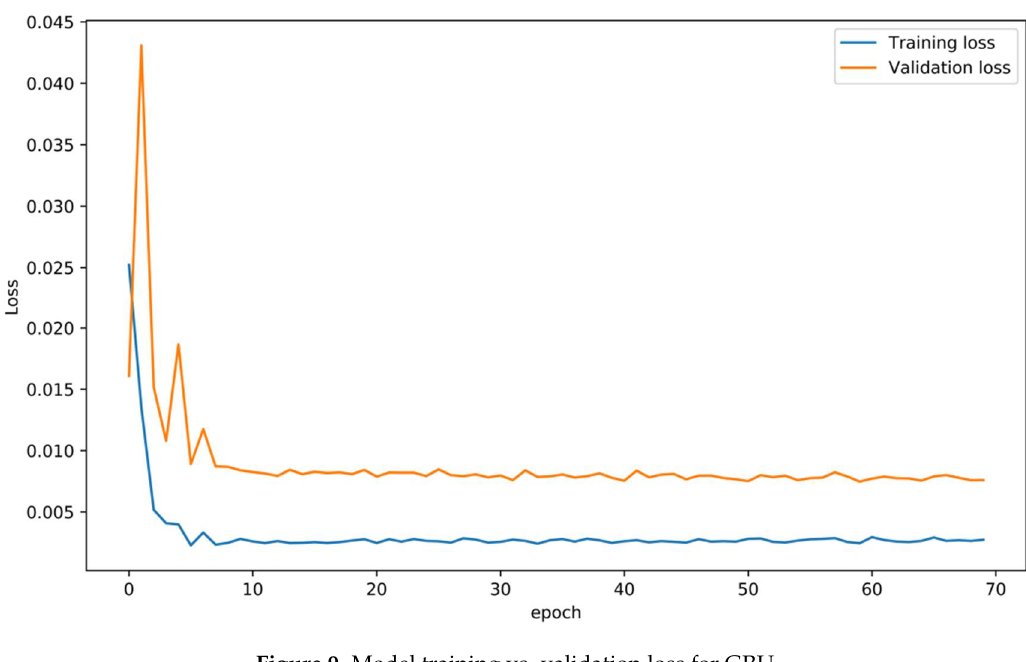
Figure 9. Model training vs. validation loss for GRU.